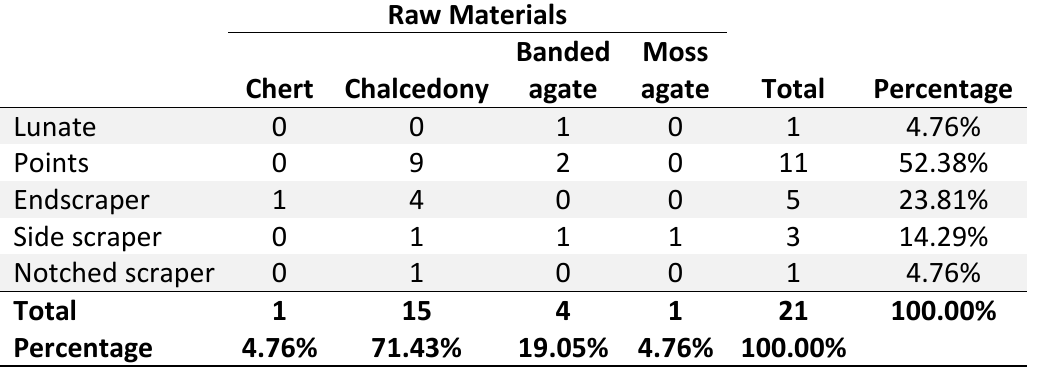
Table 3: Classification of tools according to raw material